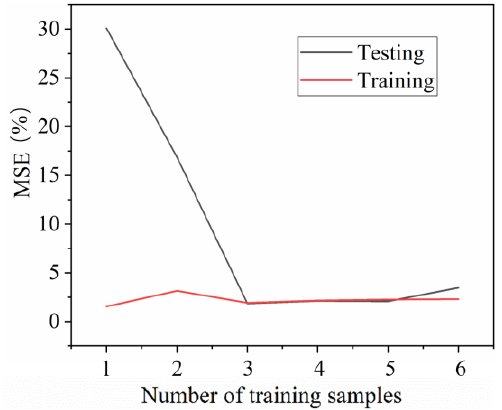
Figure 6. Learning curve of BP-ANN: variation in MSE with number of training samples for training sets (red line) and test sets (black